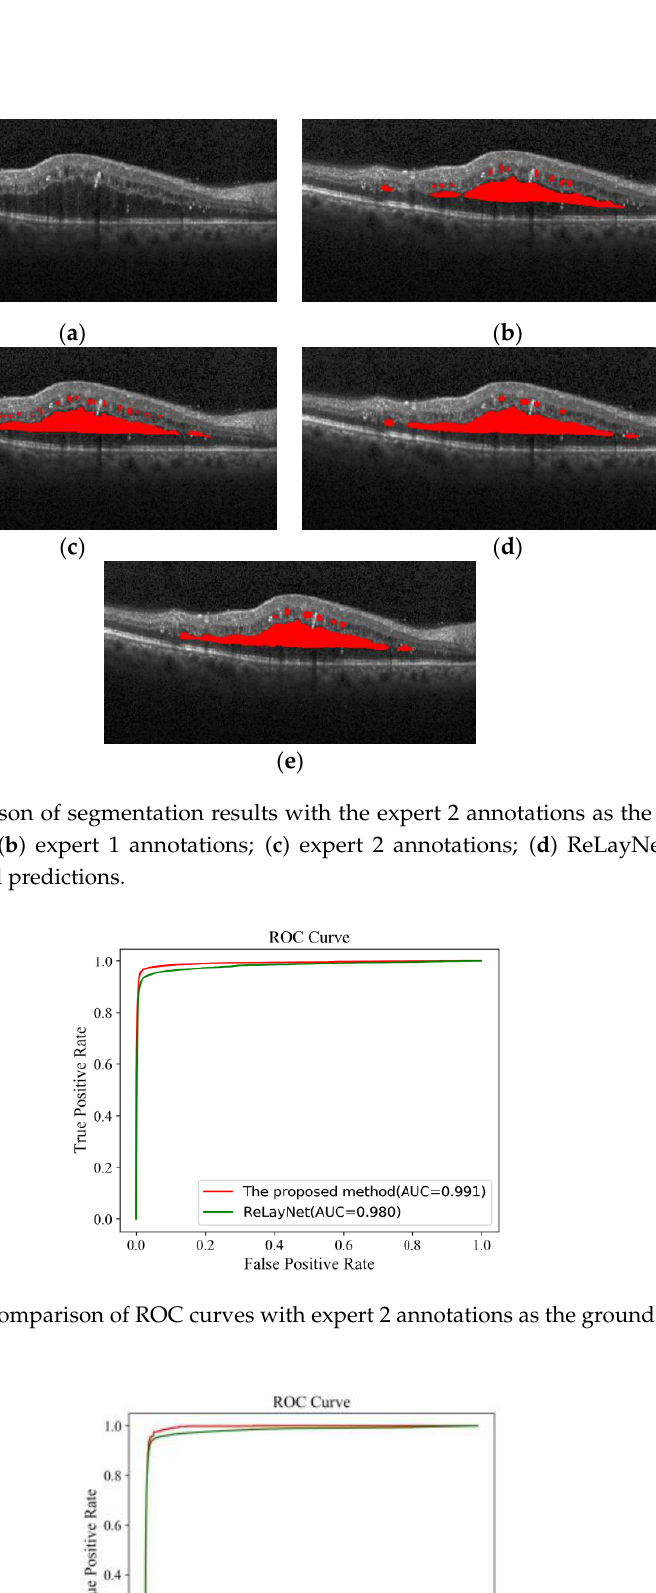
Table 7. Quantitative comparison of segmentation results around fovea edema regions for the expert 2 annotations as the ground truth.